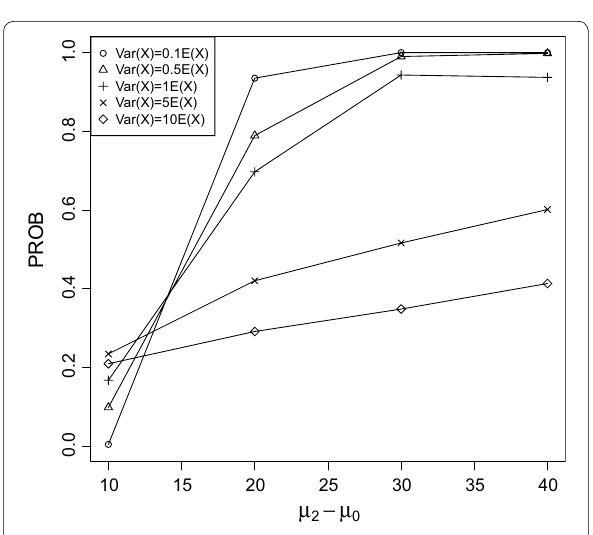
Fig. 11 PROB of the CPCAT; µ 0 = 100 , increasing trend